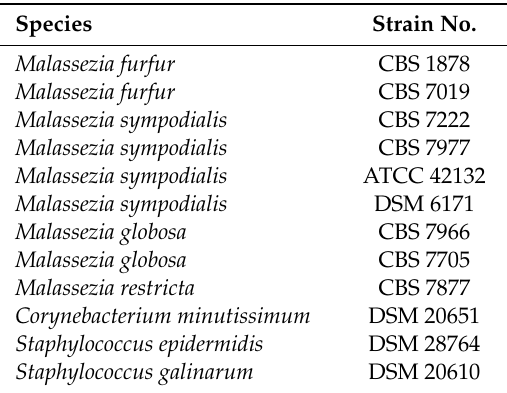
Table 3. Strains